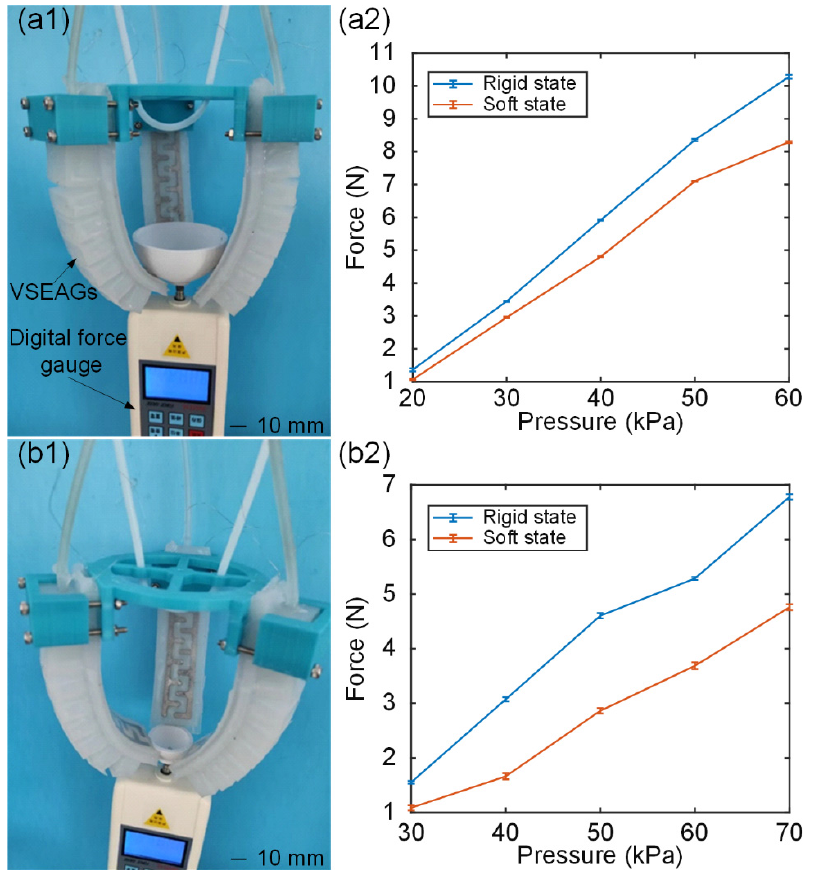
Figure 11. Gripping capability test: ( a1 , a2 ) are the envelope grasping test rig and test results, ( b1 , b2 ) are the fingertip grasping test rig and test